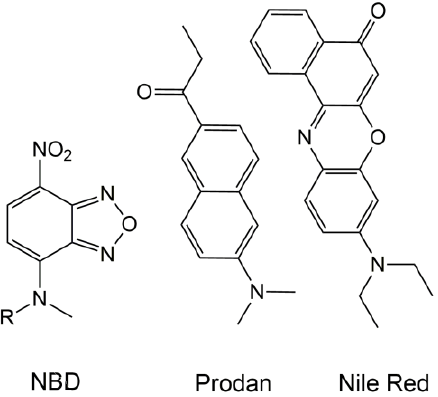
Figure 1. Structures of Common Environmentally Sensitive Fluorescent Dyes.